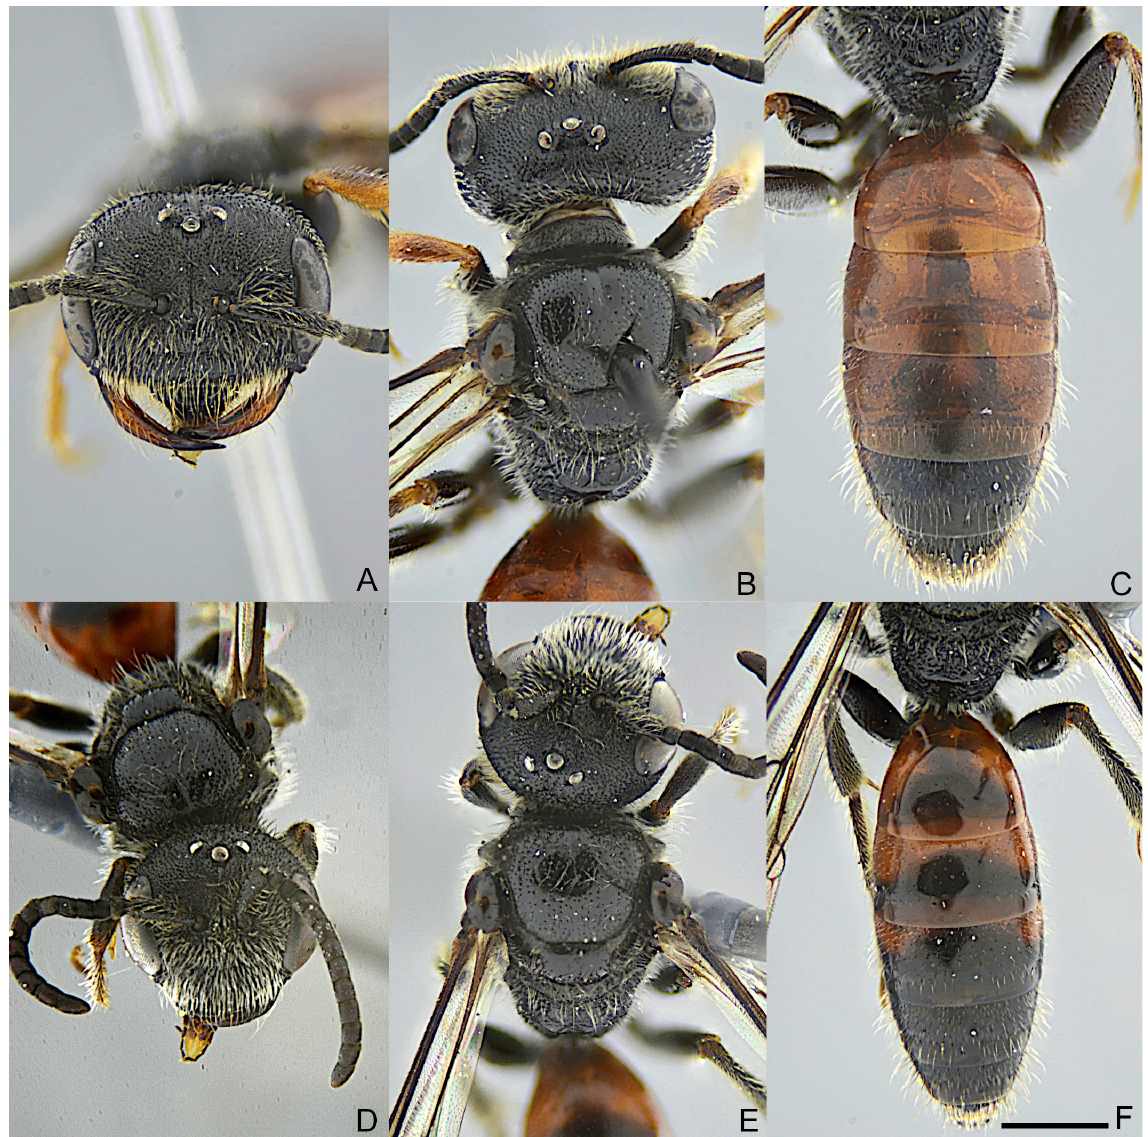
Fig. 3. Austrosphecodes cerberus sp. nov. A – C . Holotype, ♀ (DZUP 543269). D – F . Paratype, ♂ (DZUP 543276). A . Female head. B . Female mesosoma. C . Female propodeum and metasoma. D . Male head. E . Male mesosoma. F . Male propodeum and metasoma. Scale bar = 1